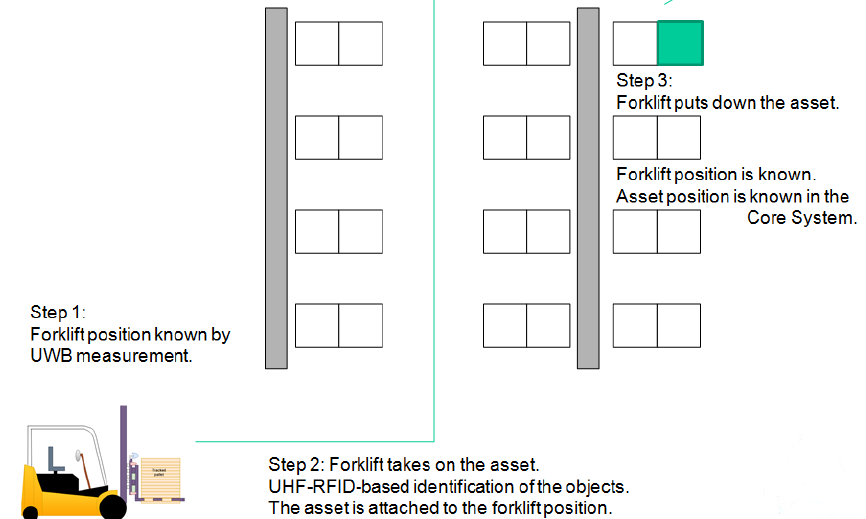
Figure 5. An example scenario for asset tracking with integrated UWB-based indoor-positioning and Ultra High Radio Frequency Identification (UHF-RFID)-based asset